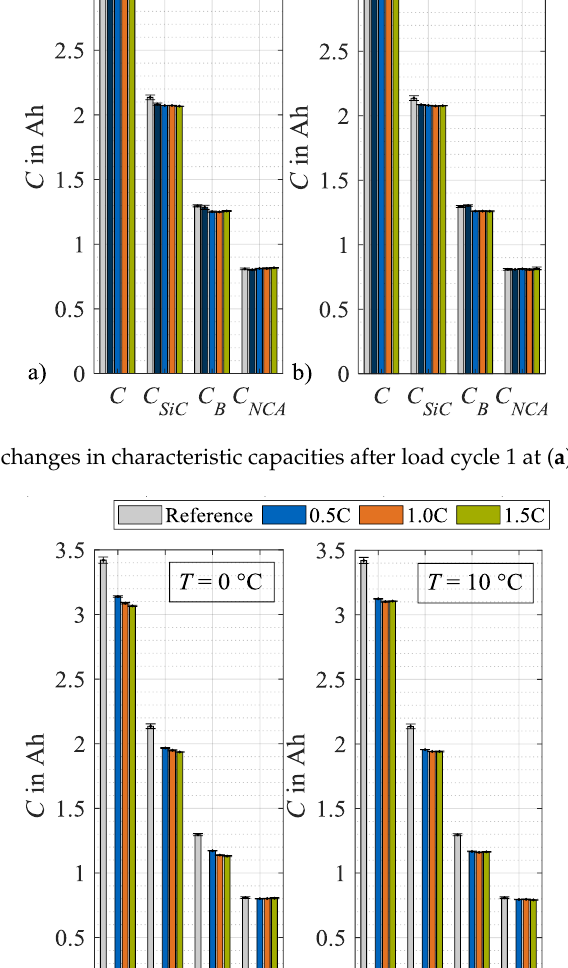
Figure 10. Absolute changes in characteristic capacities after load cycle 14 at ( a ) 0 °C and ( b ) 10 °C.